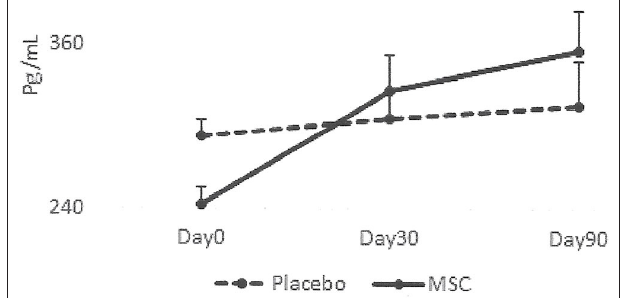
FIGURE 4 | Serum levels of IRAP in patients with improved lameness score. This graph represents IRAP concentrations in the dogs with lameness improvement in the Placebo group (2/3) vs. the dogs with improved lameness score that received MSCs (6/7) during the study. IRAP concentrations did not change significantly ( P = 0.9) in dogs with improved lameness score in the Placebo group (2/3). There was a trend showing that IRAP concentration